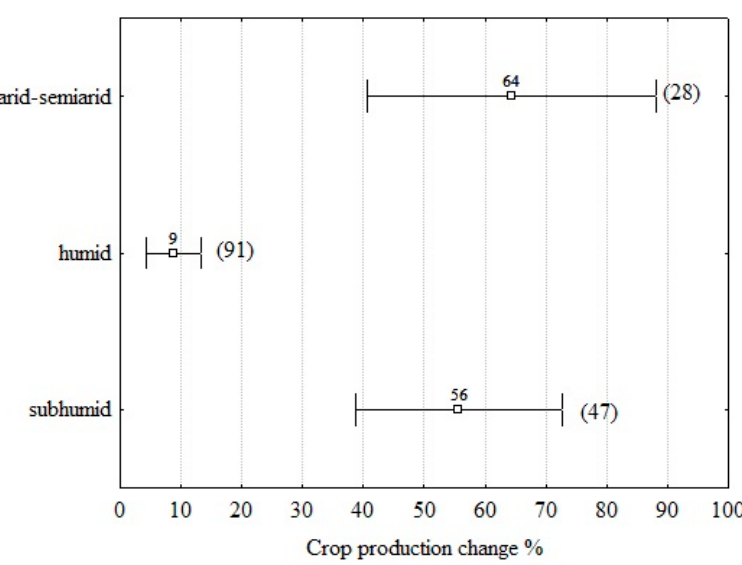
Figure 6. Mean plot of crop production change (%) in fertilization management vs. control fertilization grouped by aridity class [15]. Box–Whisker plots represent central point means, and 95% confidence interval. Numbers in brackets represent the number of comparisons used in each category. Note: the literature from the boreal zone was not as inclusive as for the other